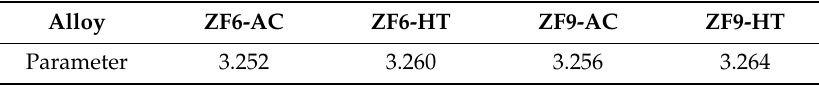
Table 4. Lattice parameter (Å) of the Nb ss in the alloys ZF6 and ZF9. Alloy